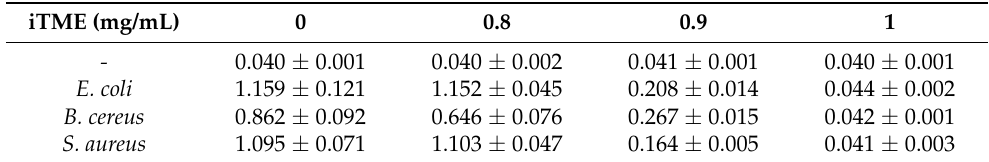
Table 2. Minimal inhibitory concentration (MIC) of immunized Tenebrio molitor larva extract against E. coli , B . cereus , and S. aureus .